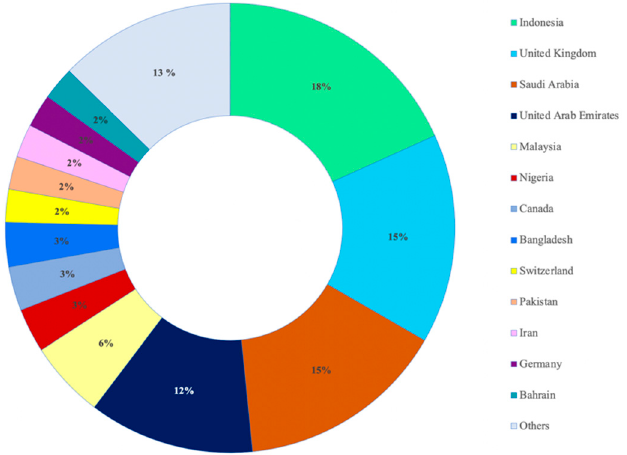
Figure 3. Islamic fintech industry annual growth, % of newcomers by country. Source: own processing based on the statements of FinTech Landscape, Finocracy.